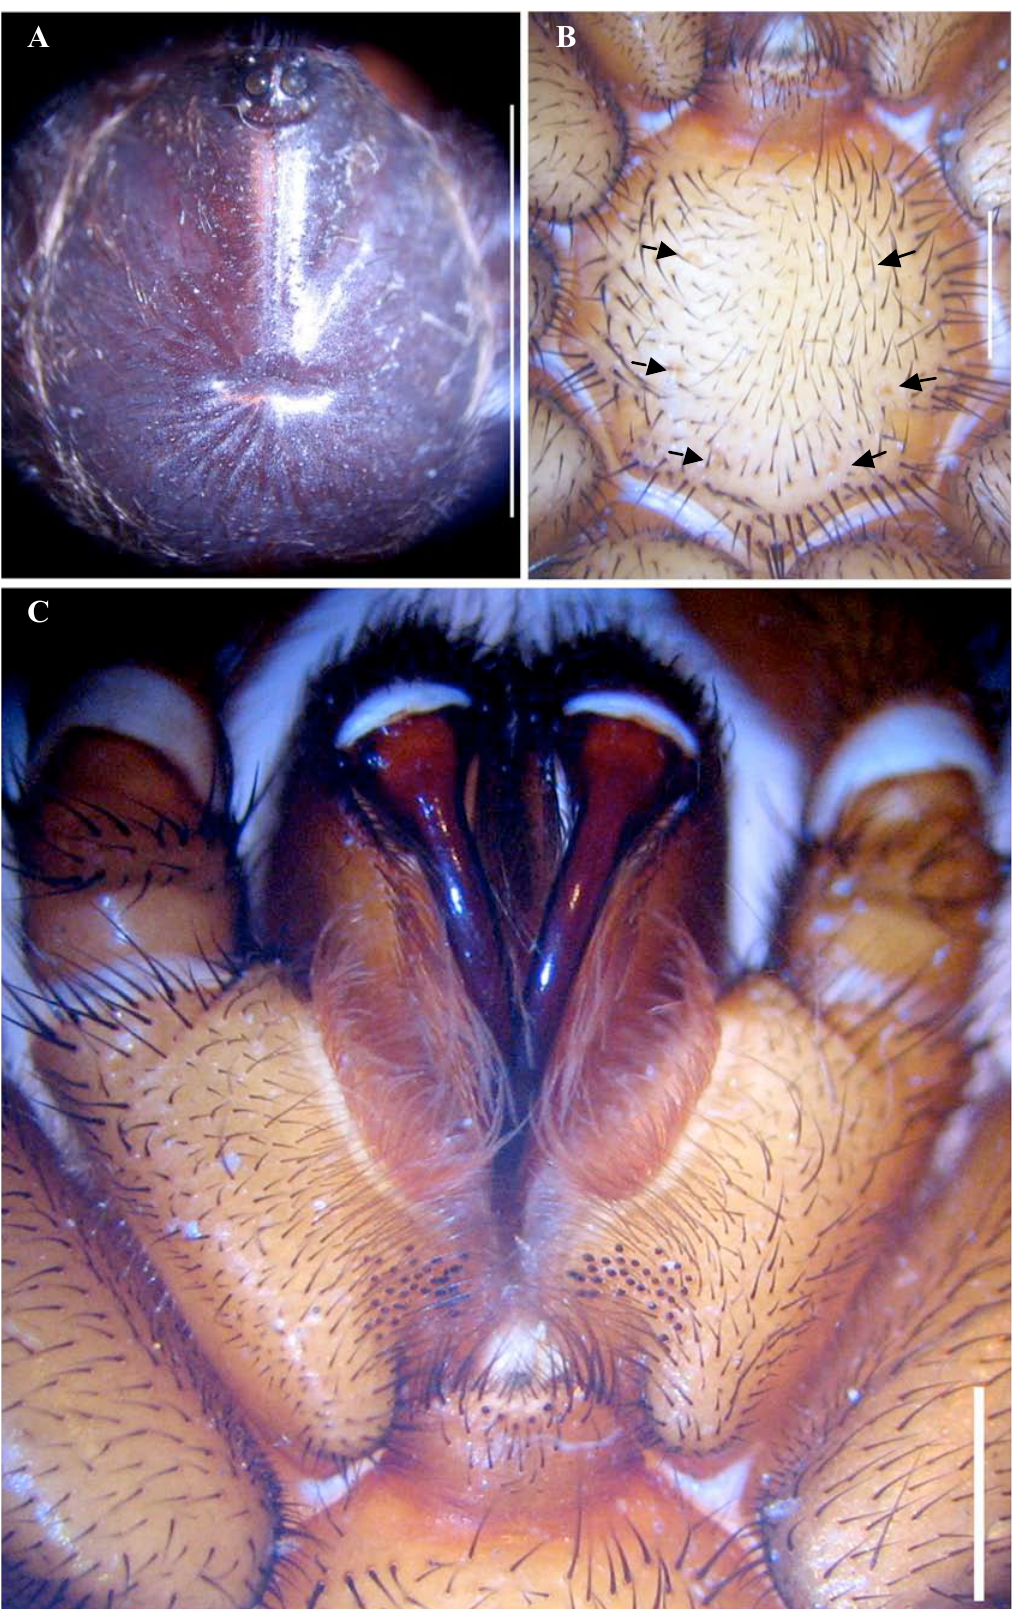
Figure 3. S. arthrapophysis male. A. Carapace, dorsal view. B. Sternum, dorsal view (arrows pointing sigilla). C. Maxillae and labium, dorsal view. (Scale for A, B = 5mm; C =